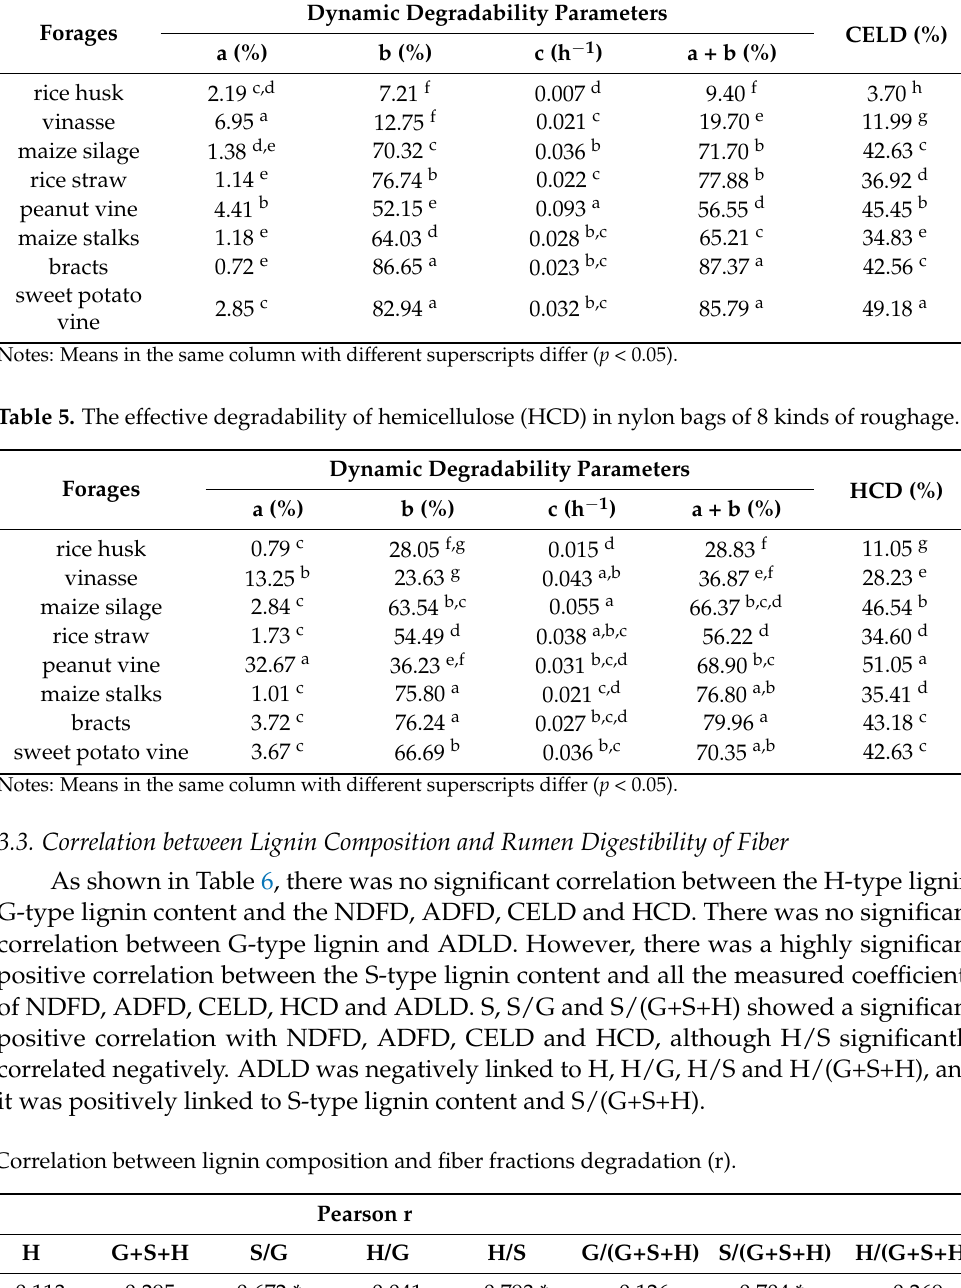
Table 4. The effective degradability of cellulose (CELD) in nylon bags of 8 kinds of roughage. Forages